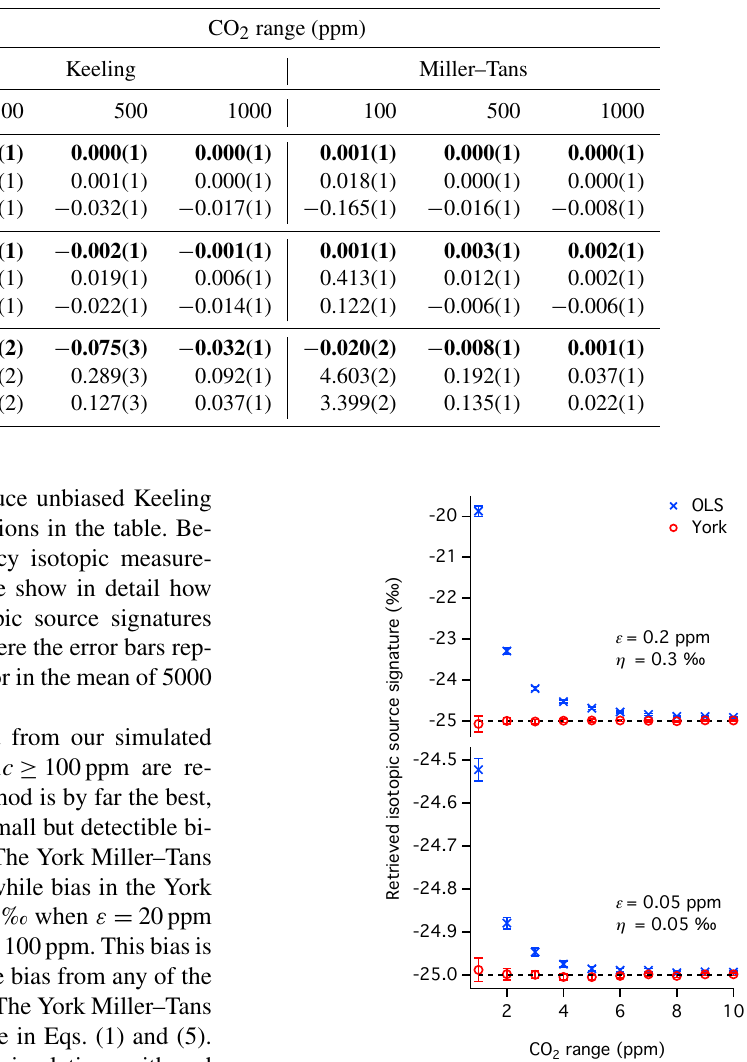
Table 2. Bias in retrieved isotopic source signatures from Keeling and Miller–Tans line fits for (cid:49)c ≥ 100ppm and η = 0 . 2‰, expressed as differences from the true value of − 25, in units of ‰. Each cell contains, from top to bottom, the York (in bold), the OLS, and the GMR result. 1 σ uncertainties in the final digit are given in parentheses, based on the standard deviation of the ensemble of 5000 fits.